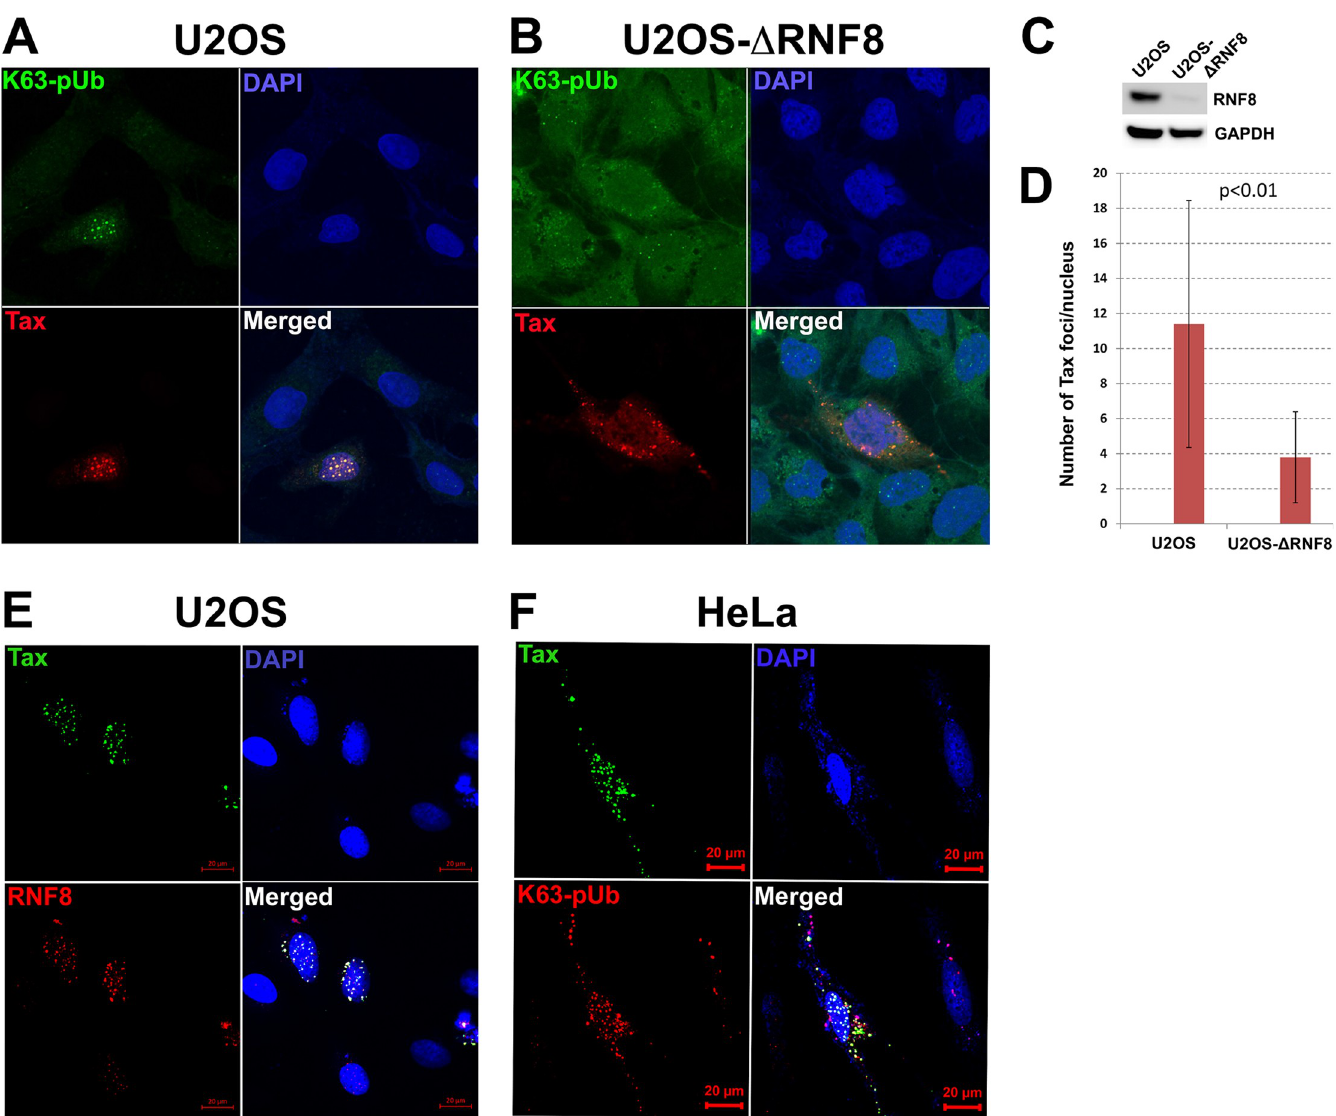
Fig 2. Formation of nuclear Tax speckle structures (TSS) requires RNF8. (A) U2OS and (B) U2OS ablated for RNF8 (U2OS- Δ RNF8) were transfected with a Tax plasmid for 48 hrs, respectively. Immuno-fluorescence was then performed to detect Tax (red) in TSS and K63-pUb chains (green, K63-TUBE (fluorescein)). Co- localization of TSS and K63-pUb chains in the nucleus (blue) are shown in the merged images. (C) Immunoblots of RNF8 and GAPDH expressed in U2OS and U2OS- Δ RNF8 cells. (D) The average numbers of TSS (Tax foci) in 17 tax -transfected U2OS and U2OS- Δ RNF8 cells were counted and compared using the student t-test. (E) U2OS and (F) HeLa cells were transfected with an expression plasmid encoding the S-tagged Tax-GFP fusion for 48 hrs as in (A) . Fluorescence microscopy was performed to detect (E) Tax (green) and RNF8 (red, by immunofluorescence) or (F) Tax and K63-linked polyubiquitin chains (K63-TUBE (TAMRA)) in TSS in the nucleus (blue). Co-localization of TSS and RNF8 or TSS and K63-pUb are shown in the respective merged images.